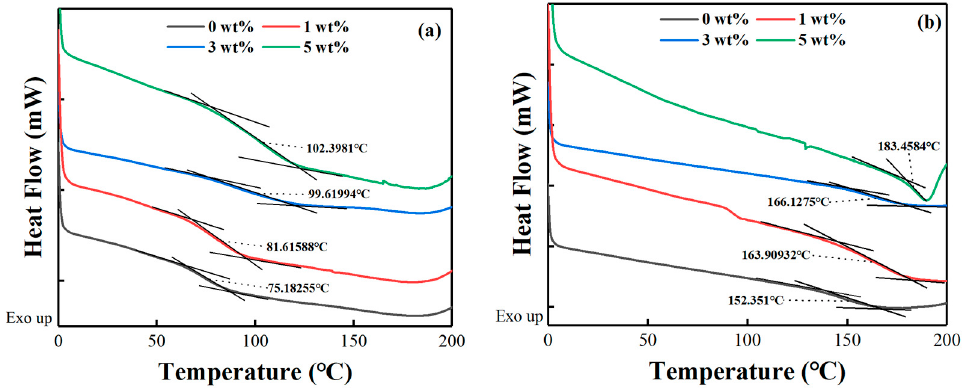
Figure 11. DSC curves of ( a ) PNE-177/DDS and ( b ) PNE-177/DICY systems at the heating rate of 5 °C/min.